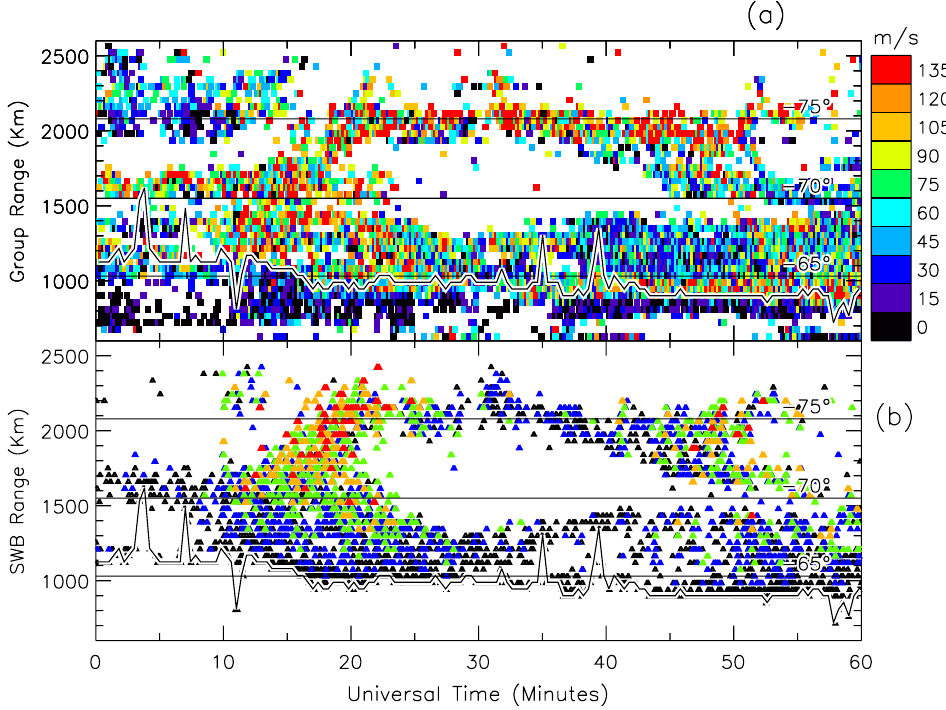
Fig. 6. (a) TIGER Tasmania observations of Doppler spectral width observed on beam 4 during 11:00 to 12:00UT on 17 December 2005. The bold fluctuating line is the 30-s running minimum in the first SWB identified along each beam (i.e. the equatorward locus). (b) The first (black), second (blue), third (green), fourth (orange) and fifth (red) SWB determined along each beam using the algorithm described in the text. The three horizontal lines represent corrected geomagnetic latitudes of − 65 ◦ , − 70 ◦ , and − 75 ◦ . Note that 3600 soundings were made per hour and the full resolution of the data cannot be reproduced at the scale of reproduction.